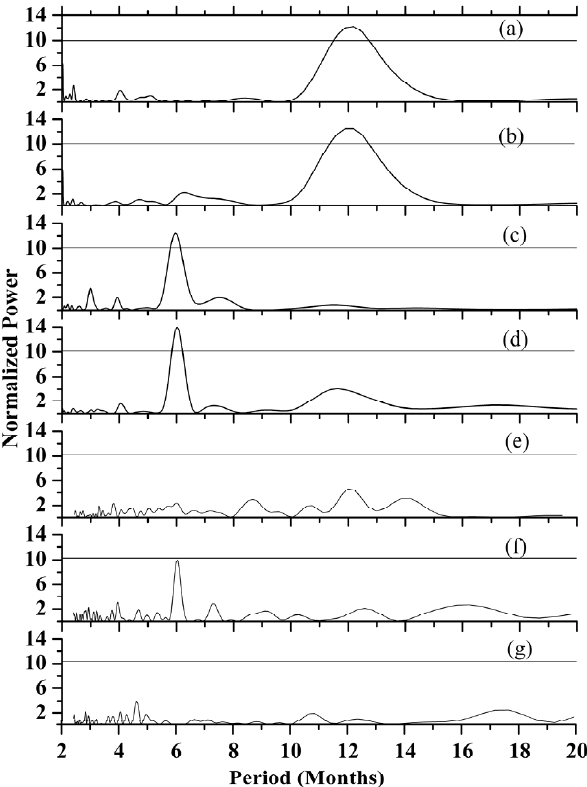
Fig.3. Lomb-Scargle periodogram using Hamming window of SABER data (Feb,2002- Fig. 3. Lomb-Scargle periodogram using Hamming window of SABER data (February 2002–December 2008) for (a) 90km, Dec,2008) for (a) 90 km, (b) 80 km, (c) 50 km, (d) 30 km and the same for lidar (e) 80 km, (f) 50 (b) 80km, (c) 50km, (d) 30km and the same for lidar (e) 80km, km, (g) 30 km. Horizontal lines represent 99.9% confidence level. (f) 50km, (g) 30km. Horizontal lines represent 99.9% confidence